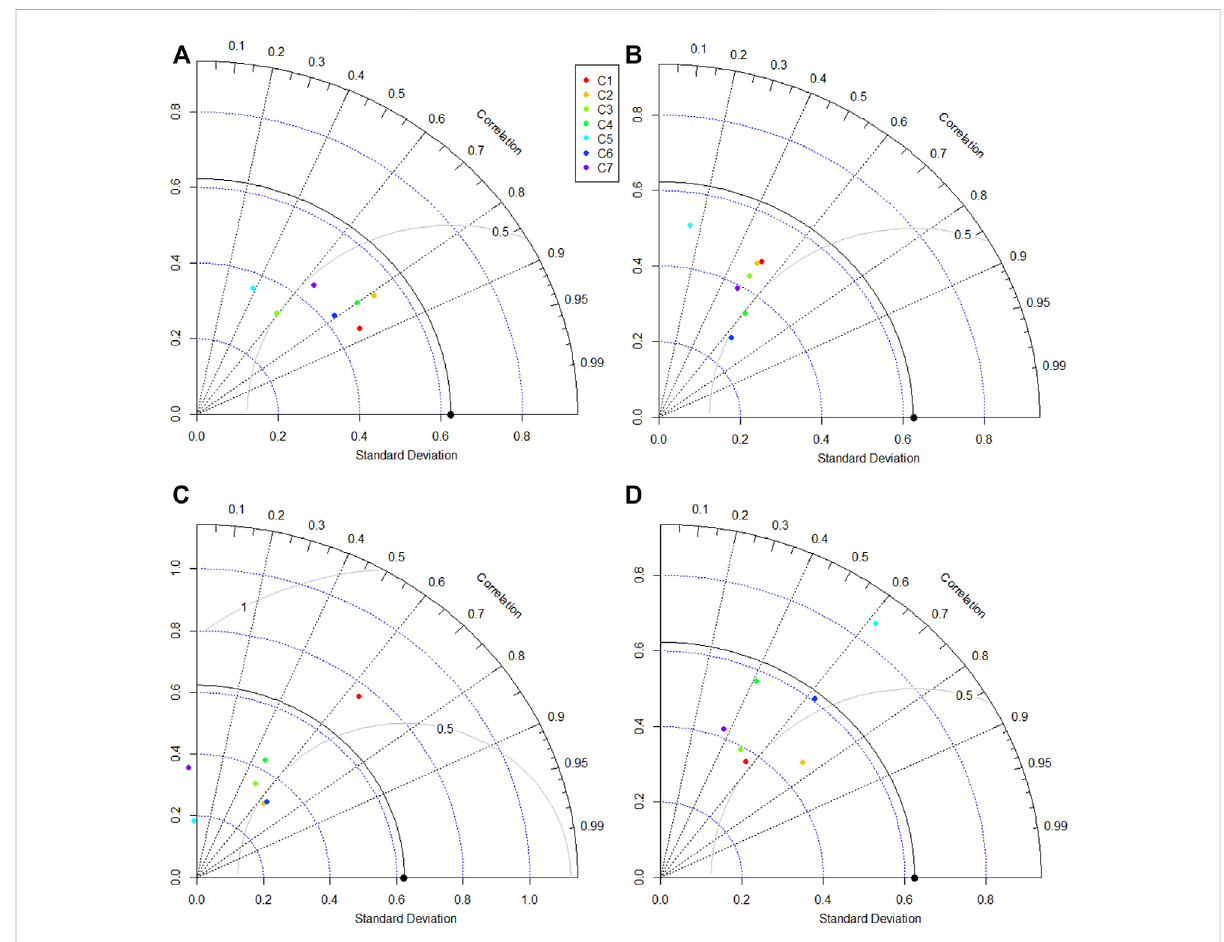
FIGURE 11 Taylordiagramofthemodelsusedto comparethecapabilityof (A) NF-GWO; (B) NF; (C) NF-SC;and (D) NF-FCMmodelsinthetestingphaseat